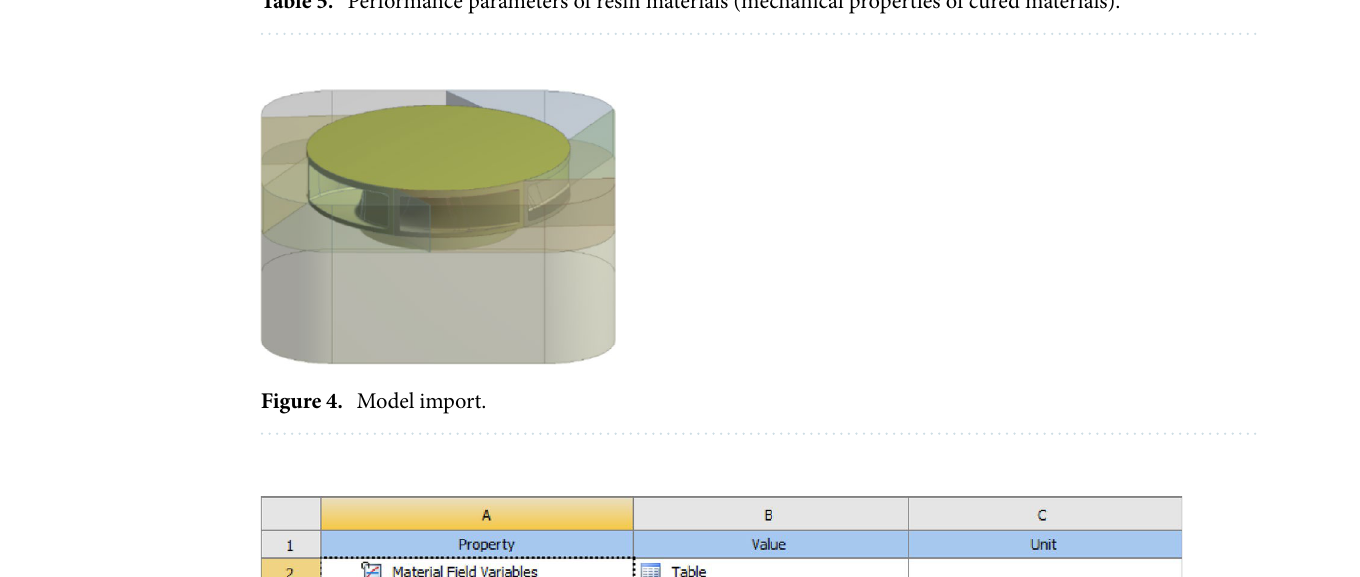
Table 5. Performance parameters of resin materials (mechanical properties of cured materials).